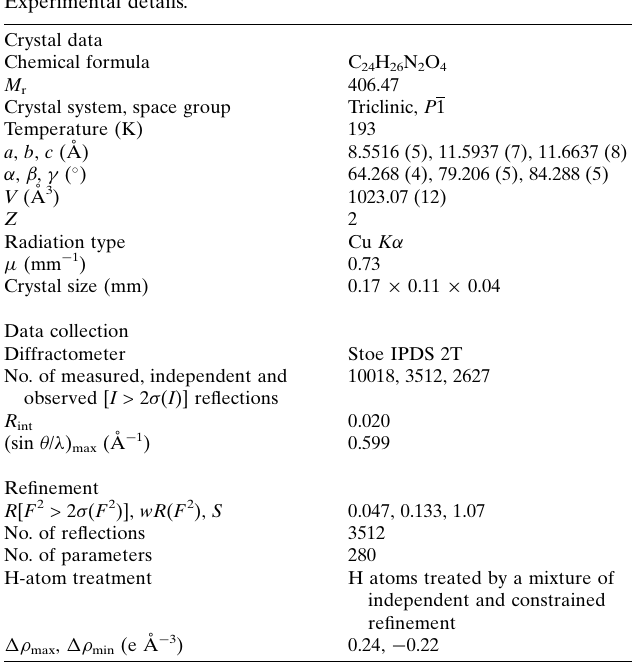
Table 2 Experimental details.